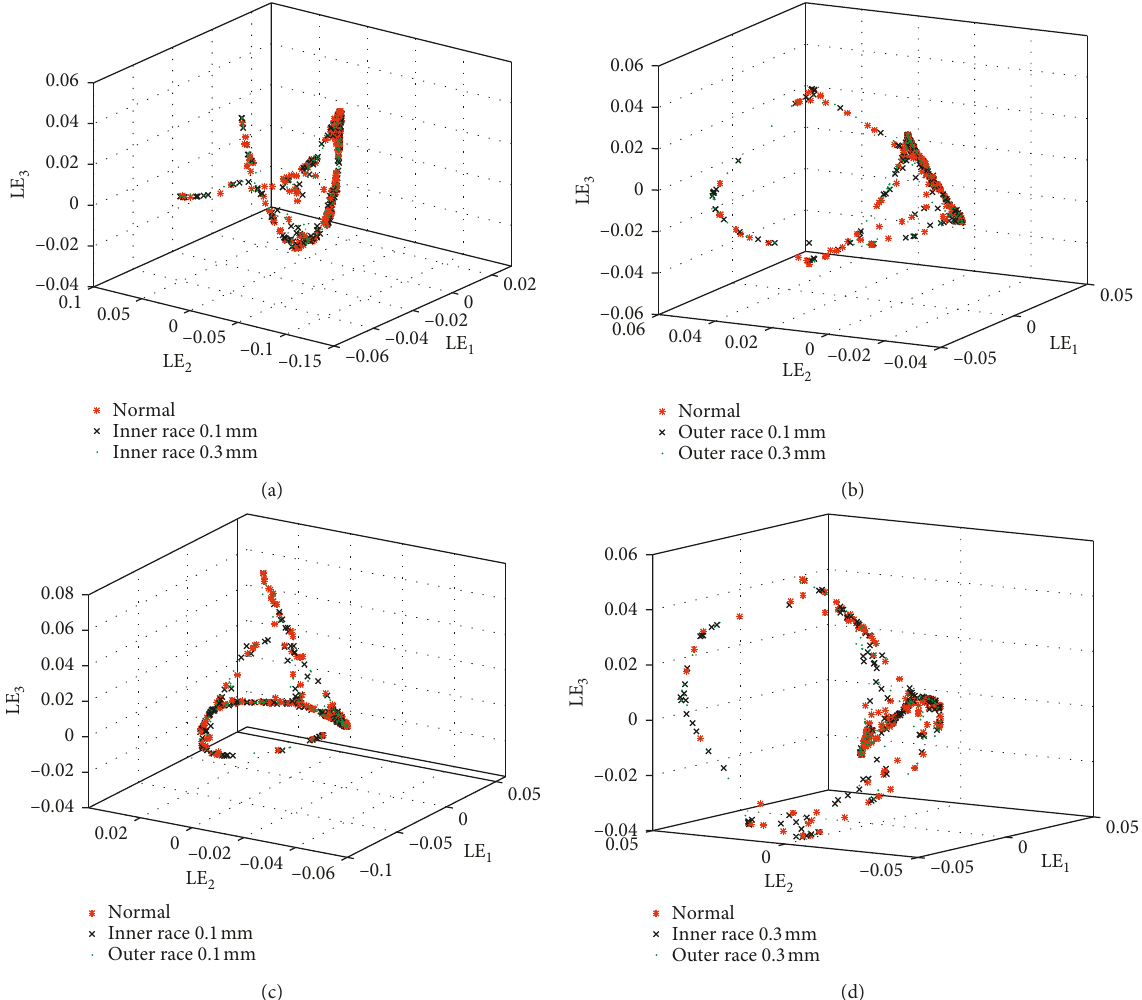
Figure 9: Mapping matrix from 23-dimensional features in reference [30]. (a) Fault set 1. (b) Fault set 2. (c) Fault set 3. (d) Fault set 4.